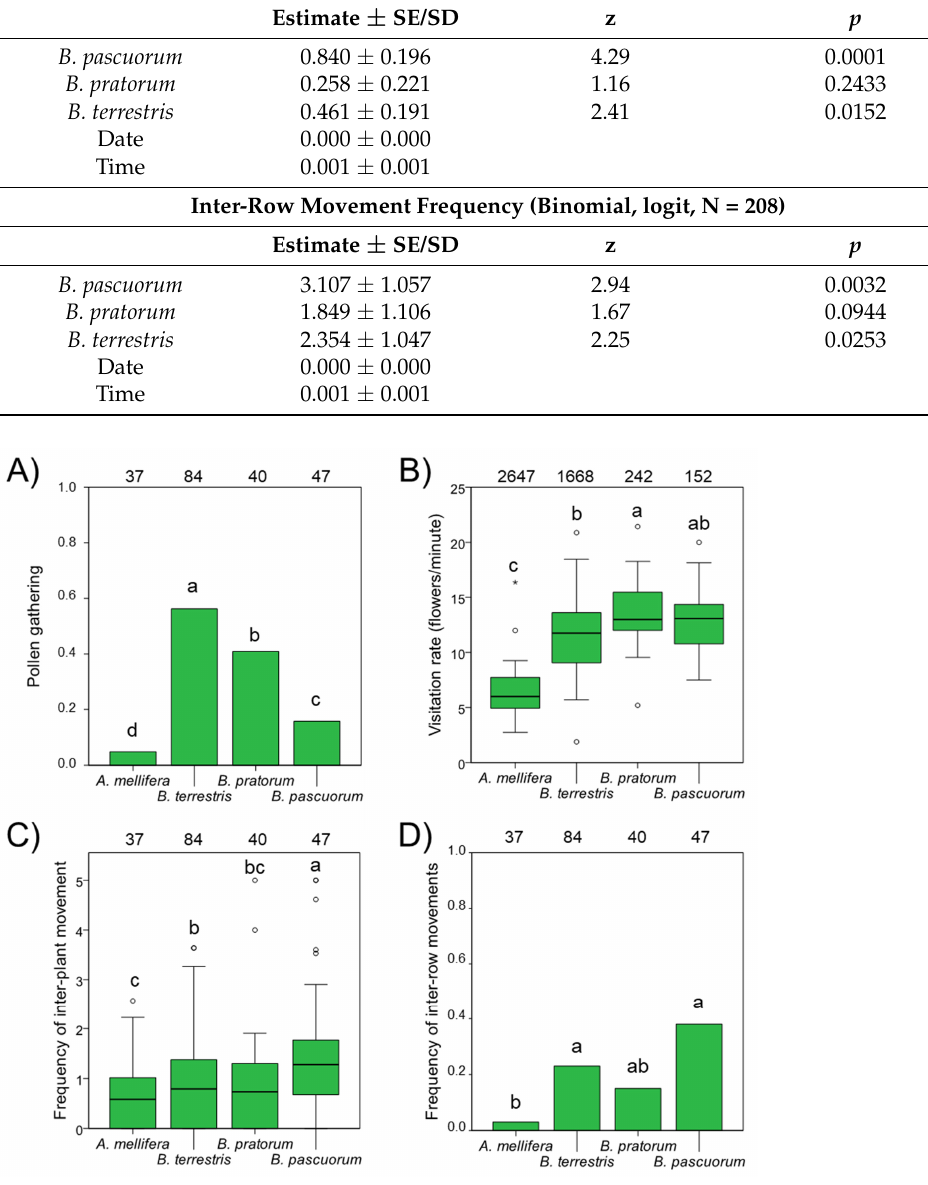
Figure 3. Pollen gathering (frequency of individuals with pollen in their corbiculae) ( A ), visitation rate (number of blueberry flowers visited per minute) ( B ), frequency of movements between plants ( C ) and between plant rows ( D ) for each pollinator species. Numbers at the top of each column indicate sample size. For each plot, different letters indicate differences between pollinator species. For ( B , C ), boxplots indicate 25–75% quartiles (box boundaries), median (thick horizontal bar), largest and smallest observed values (whiskers), outliers (small circles), and extreme values (asterisks). For each plot, different letters indicate differences between pollinator groups.